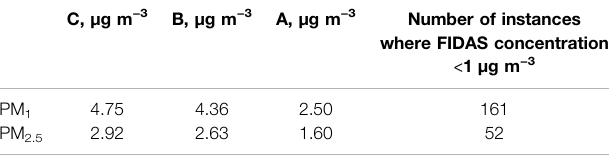
TABLE5| LoDsforcorrecteddataforAltasensePMdevicesA,B,andCforPM 2.5 and PM 1 (LoD for PM 10 was not calculated due to the limited number of instances where the FIDAS concentration was < 1 µg m − 3